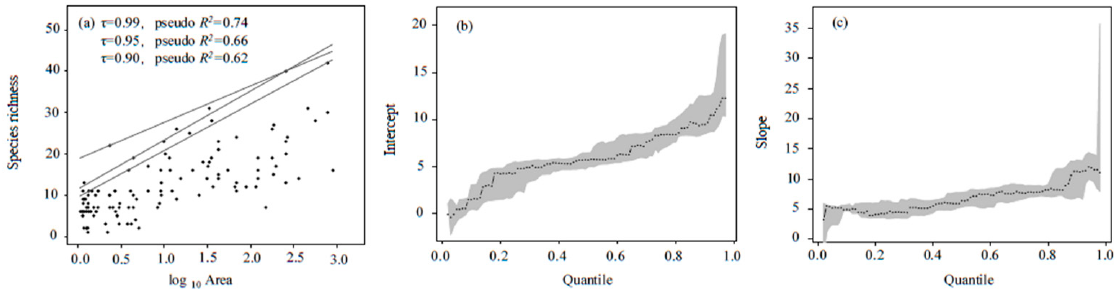
Figure 2. Quantile regression based on species–area relationships of macrobenthos ( a ) and its estimated intercept ( b ) and slope ( c ) (“ τ ” means the quantile of quantile regression, the gray areas represent 95% confidence intervals).